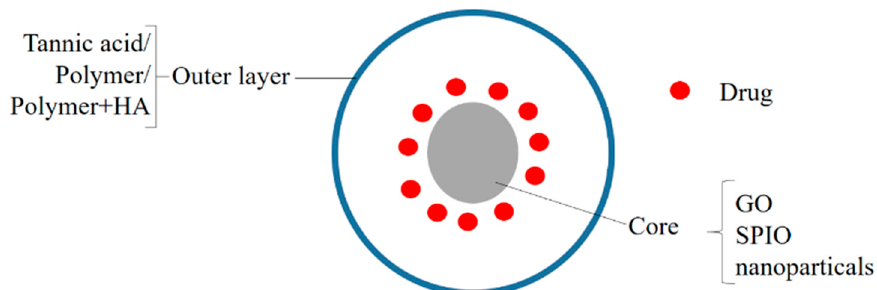
Figure 7 .A generalized structure of Poly(ethyleneimine) ‐ based nanohybrids. Figure 7. A generalized structure of Poly(ethyleneimine)-based